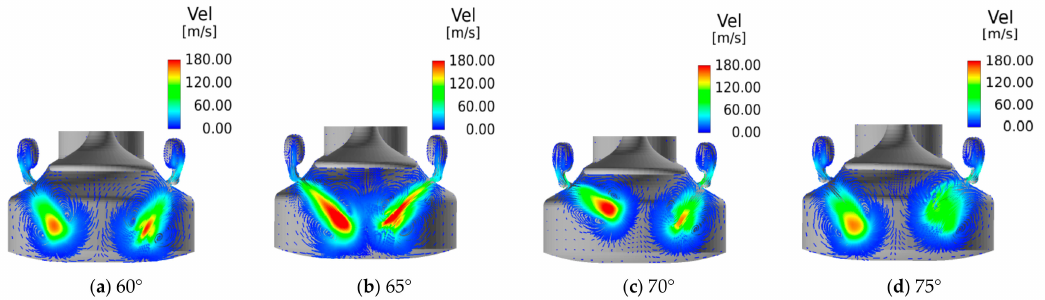
Figure 16. Flame velocity vector distribution.